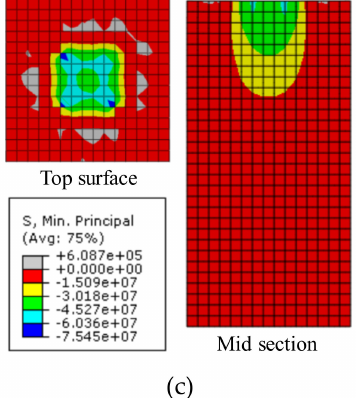
Figure 18. Minimum principal stress (Pa): ( a ) NC-150; ( b ) NC-75; ( c ) NC-50.